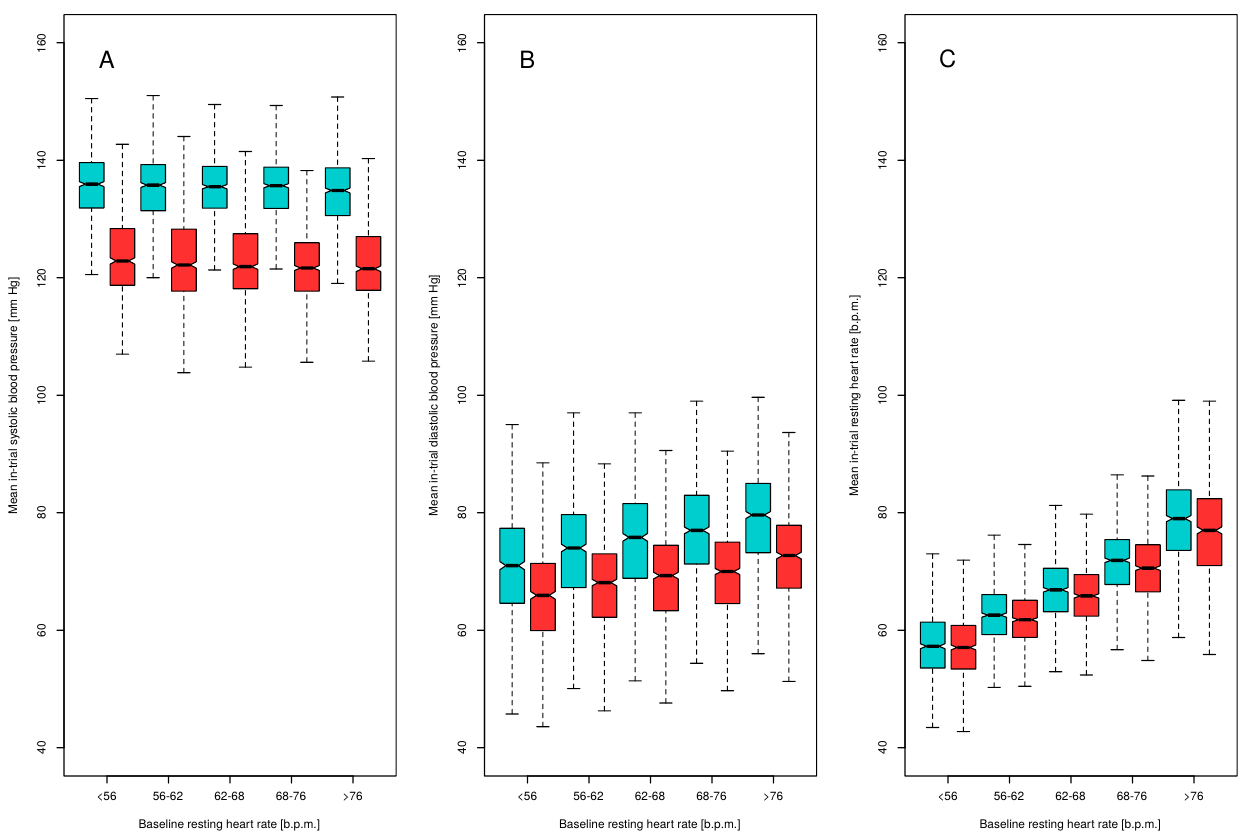
Figure 5. Mean in-trial systolic blood pressure (Panel ( A )), diastolic blood pressure (Panel ( B )), and heart rate (Panel ( C )) according to quintiles of baseline resting heart rate in the intensive (red) and standard (blue) treatment